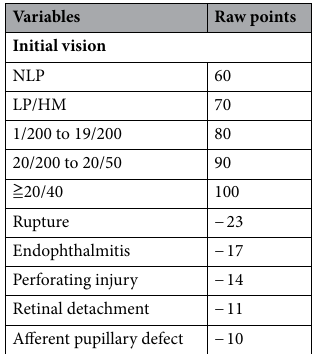
Table 1. The variables and raw points for computing Ocular Trauma Score (OTS). HM hand motion, LP light perception, NLP no light